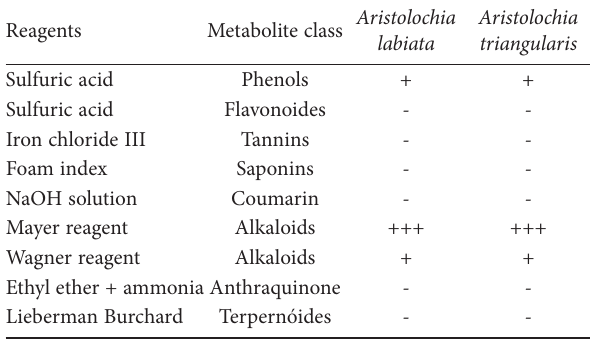
Table 1. Qualitative phytochemical analysis of Aristolochia labiata and Aristolochia triangularis